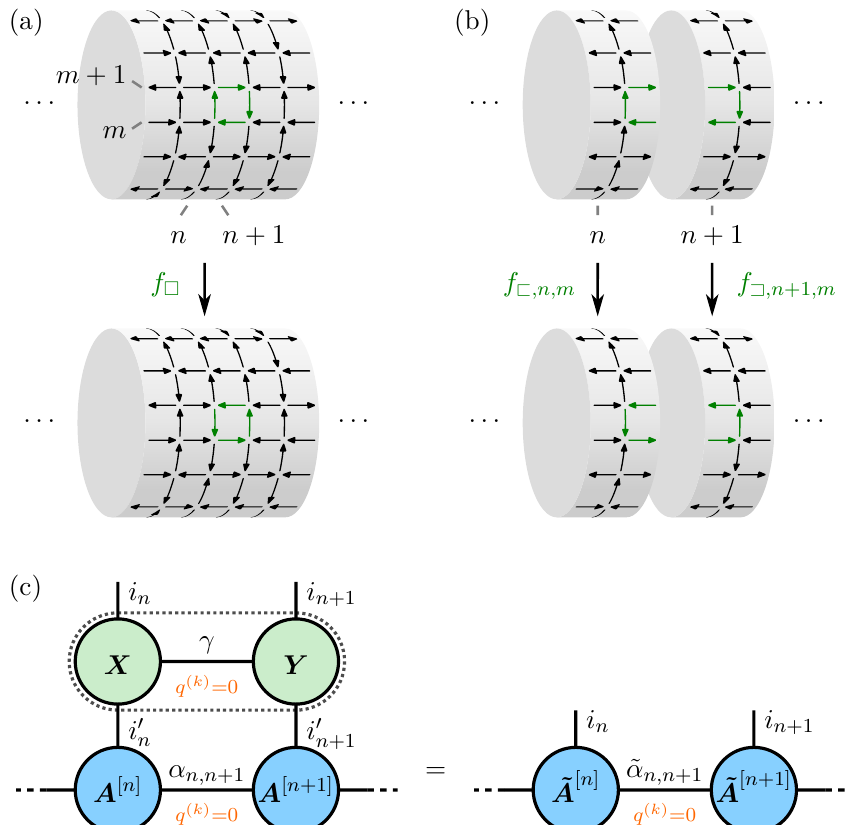
Figure 13: Mapping the Hamiltonian into nearest-neighbour form suitable for TEBD. (a) The plaquette-operator f (cid:131) is applied to an oriented plaquette (green) spanning sites m , m + 1 and n , n + 1 on the original lattice. (b) In our computational basis, f (cid:131) factors into nearest-neighbour operators f (cid:192) and f (cid:193) , acting separately on , n , m , n + 1, m MPS sites n and n + 1. (c) The application of the nearest-neighbour evolution operator ( τ ) is made computationally efficient by avoiding the full four-indexed tensor ˜ U n , n + 1 of standard TEBD (dotted line). Instead, two three-indexed tensors X , Y (green) are contracted separately into MPS tensors A [ n ] and A [ n + 1 ] , followed by a re-compression of the bond-index ˜ α to the maximal bond-dimension. The gauge-symmetry is n , n + 1 reflected by the U ( 1 ) invariance of all tensors. In compliance with the constraints on the MPS bonds, the index γ , which runs over all pairwise interactions, carries quantum number q ( k ) = 0 for k ≡ n ( mod 2 )